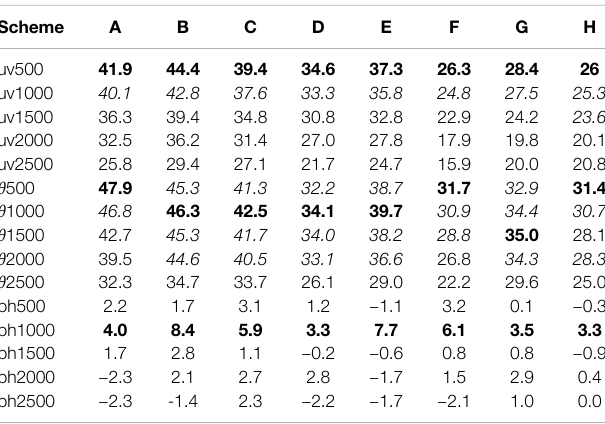
TABLE 3 | Same as Table 2 , except for simulated meteorological fi elds at standard pressure layers.